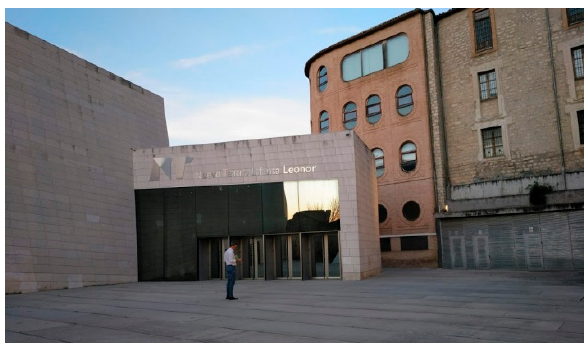
Figure 1. View of the theater [43] located on one side of the square.